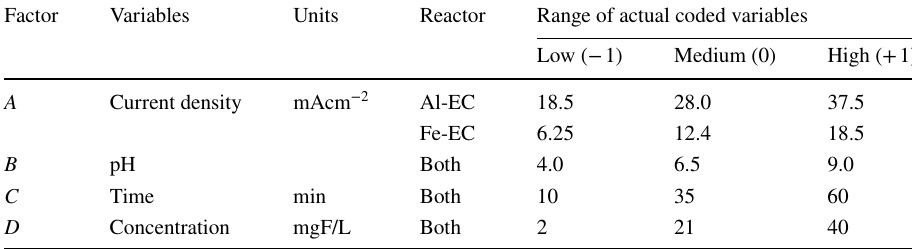
Table 1 Experimental range and levels of independent variables for Al-EC and Fe-EC